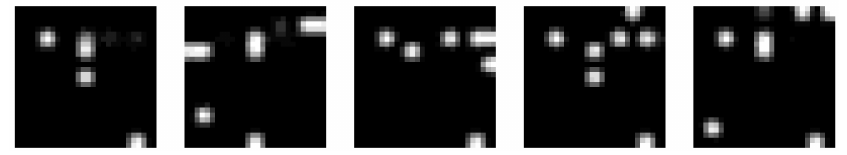
Figure 3. Sample images for each class (Normal, DoS, Probe, R2L, and